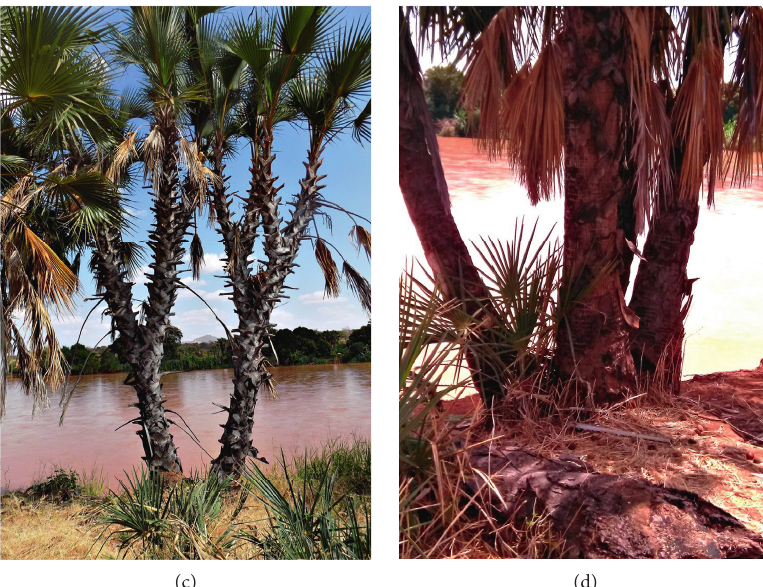
Figure 4: Branching morphology of H. compressa : (a) Single-trunk morphology showing low fruiting height in Kwale. (b) Two-trunk branching above the ground. (c) Two-trunk branching on the ground, middle, and top forming 8 crowns. (d) More than two-trunk branching at the ground level.